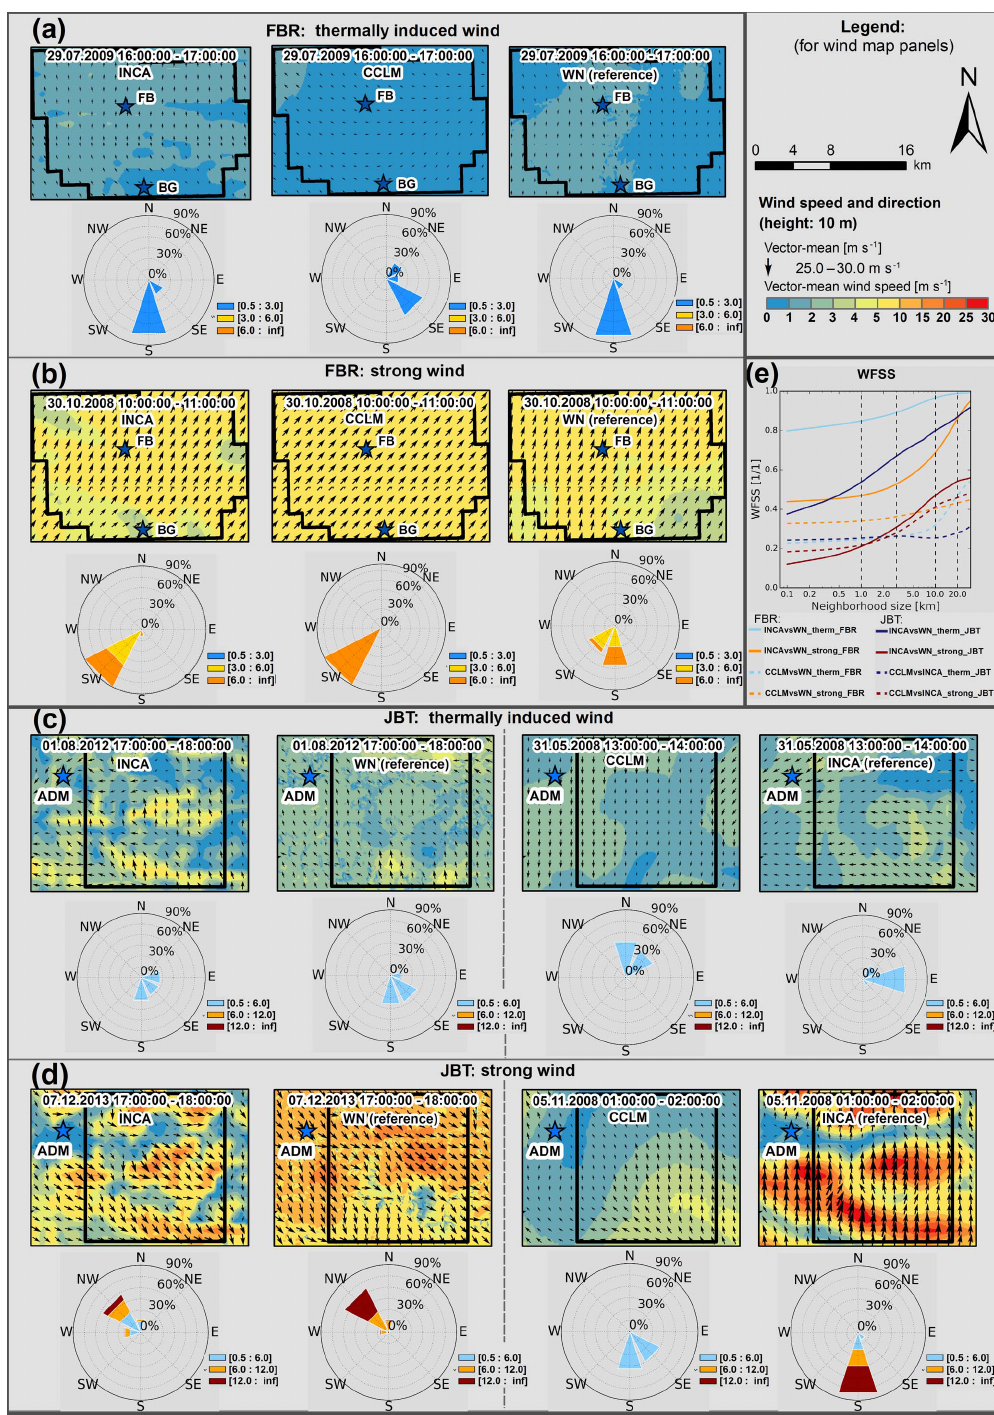
Figure 2. Wind fractions skill score (WFSS) analysis for selected 1h wind fields for the WegenertNet FBR (a, b) and the WegenerNet JBT region (c, d) . (a) – (d) Modeled and reference wind fields (first row) and corresponding relative frequency of wind directions for a range of wind speed categories (second row) in each panel. (e) WFSS results for the modeled versus reference wind fields from (a) to (d) . See Table 1 for more information on the evaluation